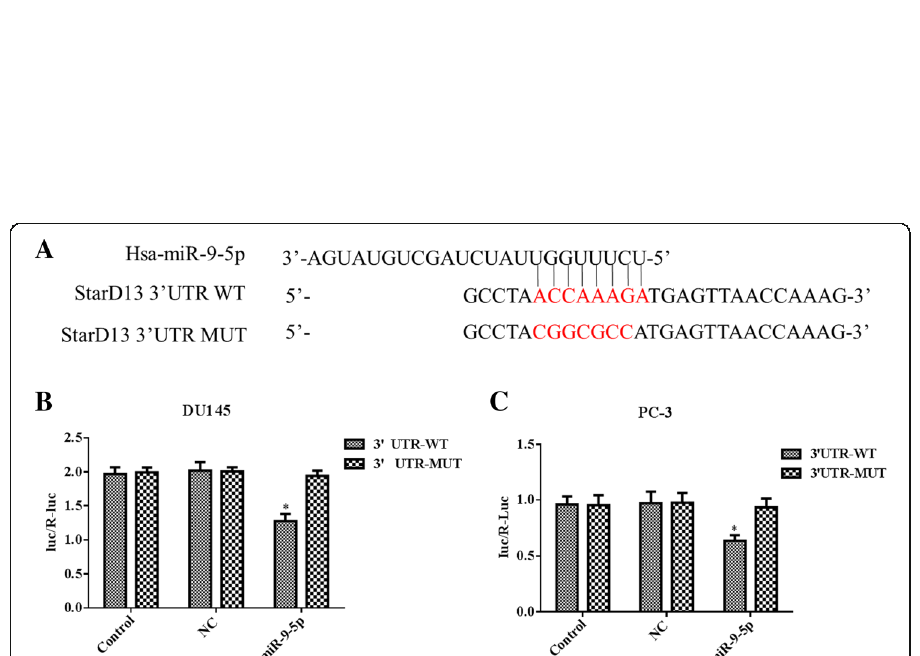
Fig. 9 StarD13 is a direct target of miR-9-5p. a The 3 ′ -UTR of StarD13 mRNA was found to contain the complementary sequence of miR-9-5p. b and c Downregulated miR-9-5p expression significantly suppressed the dual-luciferase activity of the wild-type (WT) 3 ′ -UTR of StarD13 but not the mutant (MUT) 3 ′ -UTR of StarD13 in DU145 cells ( b ) or PC-3 cells ( c ). * p < 0.05 vs. 3 ′ -UTR MUT. All experiments were performed with at least three replicates